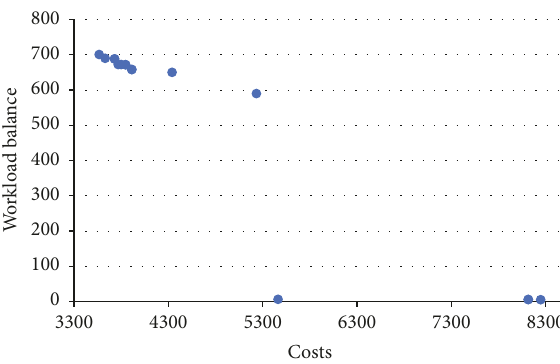
Figure 9: Approximation of the Pareto front of Instance 8.